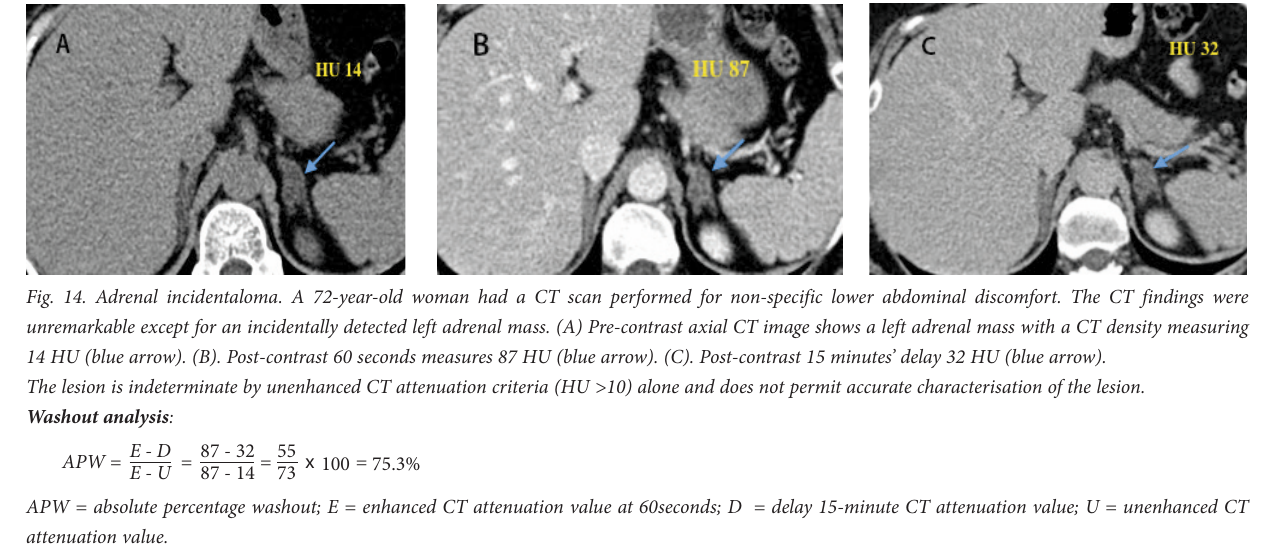
APW = absolute percentage washout; E = enhanced CT attenuation value at 60seconds; D = delay 15-minute CT attenuation value; U = unenhanced CT attenuation